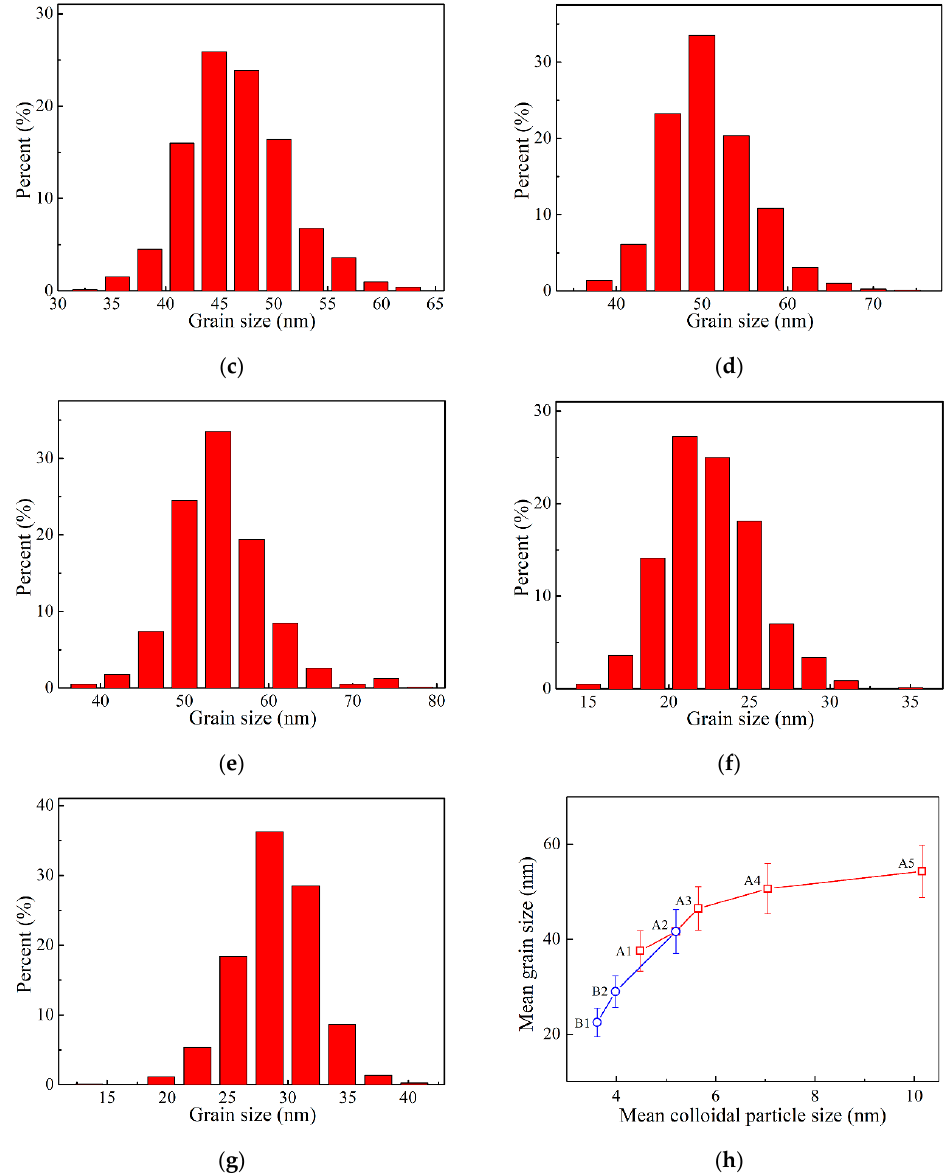
Figure 9. The grain size distribution of alumina fiber: ( a ) Sample A1, ( b ) Sample A2, ( c ) Sample A3, ( d ) Sample A4, ( e ) Sample A5, ( f ) Sample B1 and ( g ) Sample B2. ( h ) The relationship between mean grain size and mean colloidal particle size.